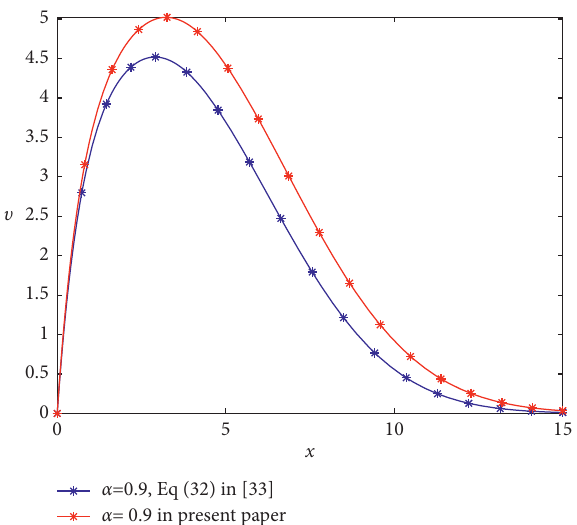
Figure 15: Comparative studies concerning the velocity distribution.